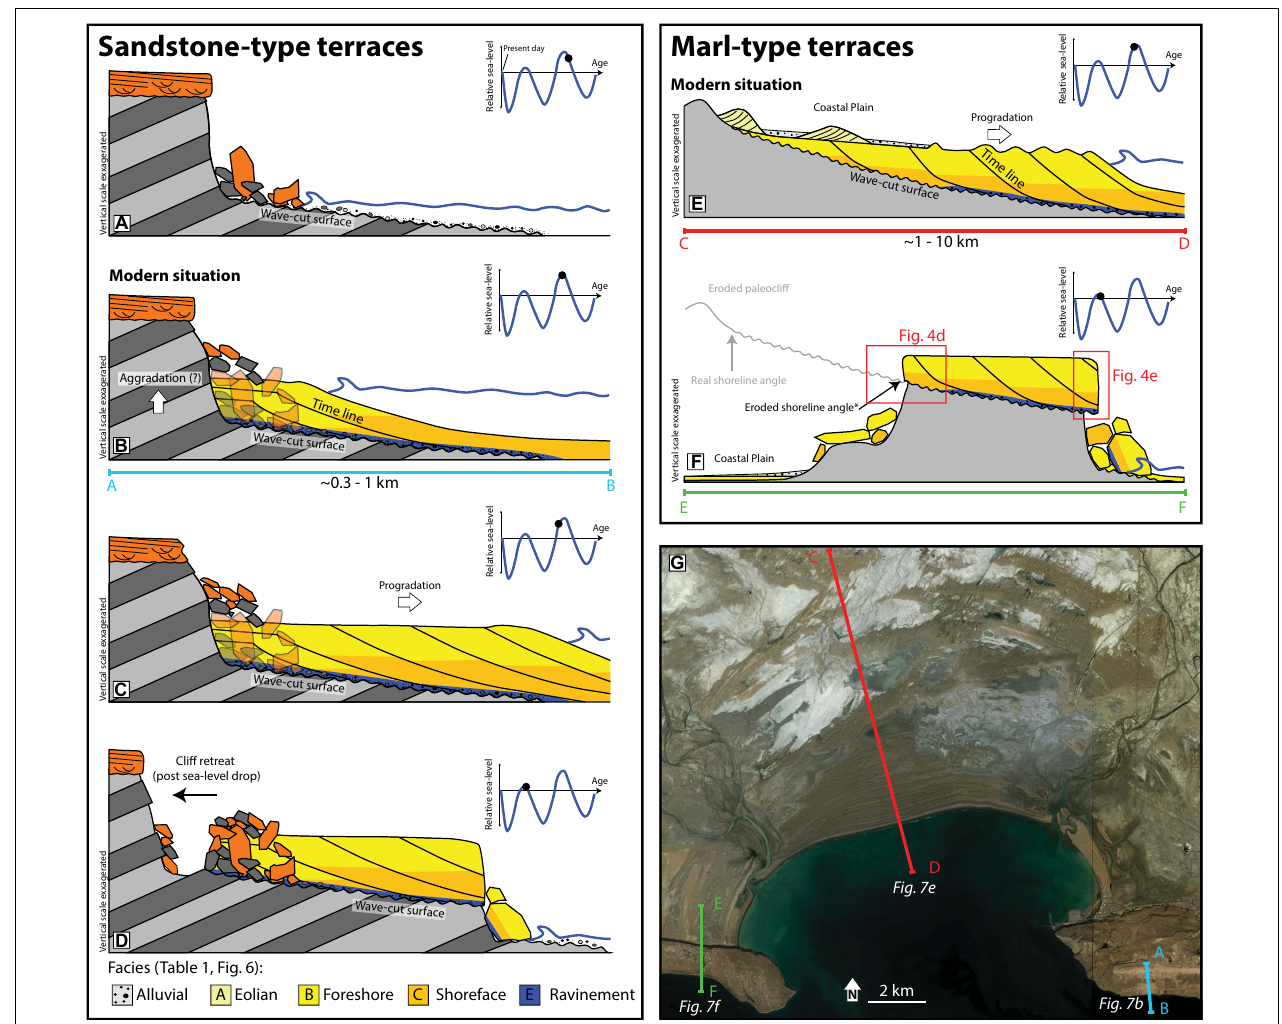
FIGURE 7 | Interpretation of the Mmt development as sea-level varied through time. (A–D) Model for sandstone-type terraces. (A) Start of the highstand, carving of the wave-cut platform. (B) Post-peak of the highstand, start of beach deposition, as seen currently in the Makran headland beaches (e.g., Figure 4A foreground). (C) End of highstand, start of sea-level fall. Rapid beach progradation across the shallow platform. (D) Next highstand, after relative sea-level fall, the paleobeach is now found as a marine terrace. The paleocliff seems to be eroding further after platform abandonment, as its current position can be a few tens of meters from the megaboulders delineating the original position of the shoreline angle (Normand et al., 2019a, images CH5-6 and LI4). (E,F) Model for marl-type marine terraces. (E) After platform carving into the soft marl, the bay beach develops in a series of prograding beach ridges, as seen currently along the Makran (e.g., Figures 1 , 7G ). Note the difference in lateral extension compared to sandstone-type terraces. (F) Situation at the next highstand, the beach is uplifted into a marine terrace (e.g., Figures 4B,F ). (G) Satellite image (Bing) of Pozm bay and surroundings, illustrating modern equivalents of some of these sketches. More examples illustrating these profiles in Figures 8 , 9